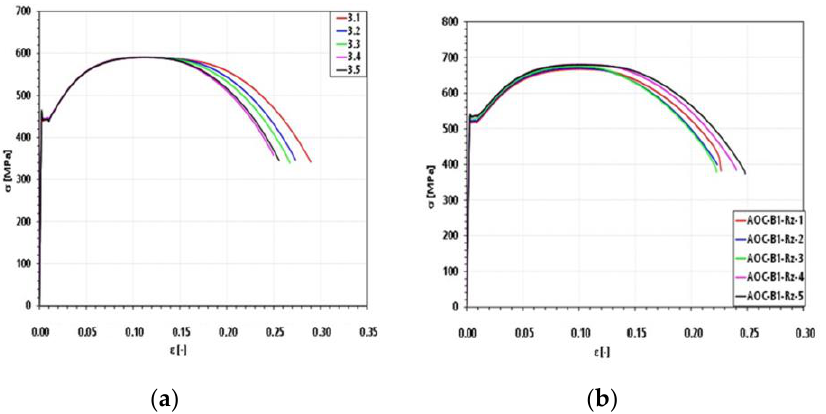
Figure 8. Stress-strain curves for each material during preliminary examinations: ( a ) 20MnMoNi5-5 and ( b ) 22NiMoCr3-7.